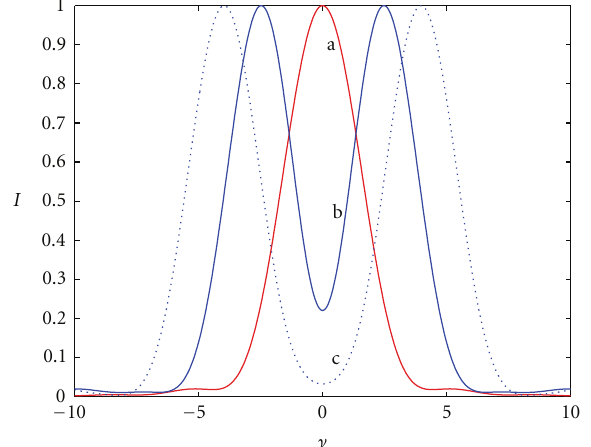
Figure 4: Degree of polarization along π /4 in focal plane of an aplanatic lens with NA = 0 . 9 of uniformly polarized vortex beams . 5, β = π/ 2, for m (a) 0 (b) 1, and (c) μ o = 0